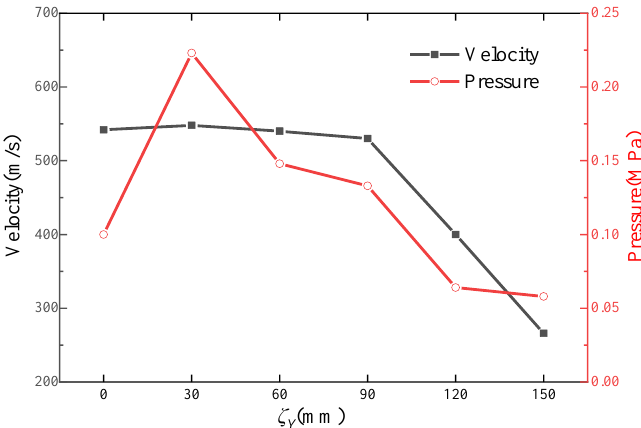
Figure 17. Jet velocity and pressure of different ignition positions.